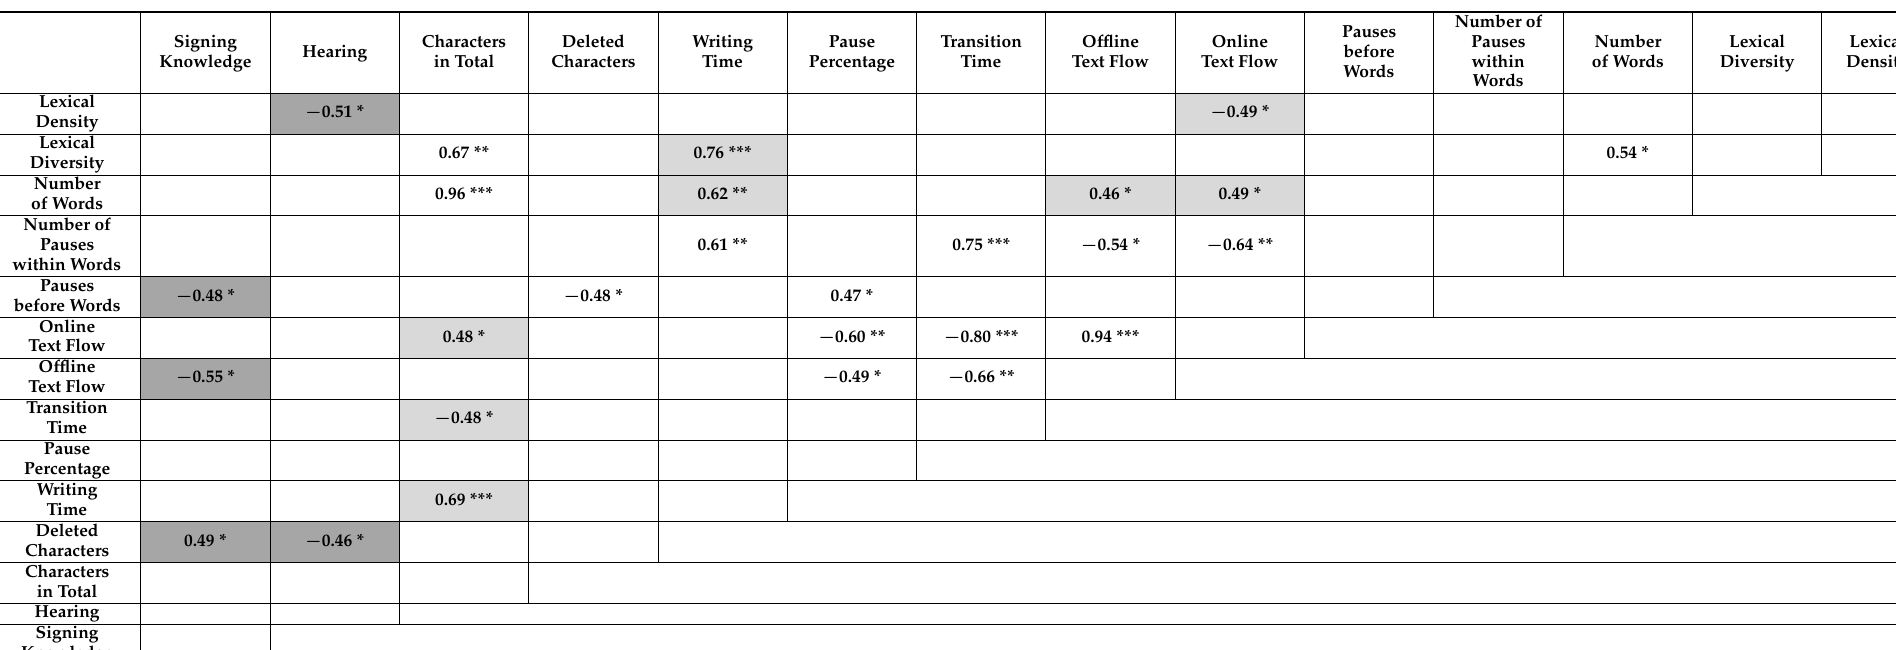
Table 5. A correlation matrix of the examined measures. A * shows significance at p ≤ 0.05 level, ** shows significance at p ≤ 0.01 level, *** shows significance at p ≤ 0.001 level. Dark gray indicates the correlations between the variables signing knowledge and hearing (DHH/CODA) and the writing outcomes. Light gray indicates the correlations between a written product and a writing process. The empty boxes show no correlations. OBS: The measures pauses within words and spelling errors were removed from the matrix because there were no